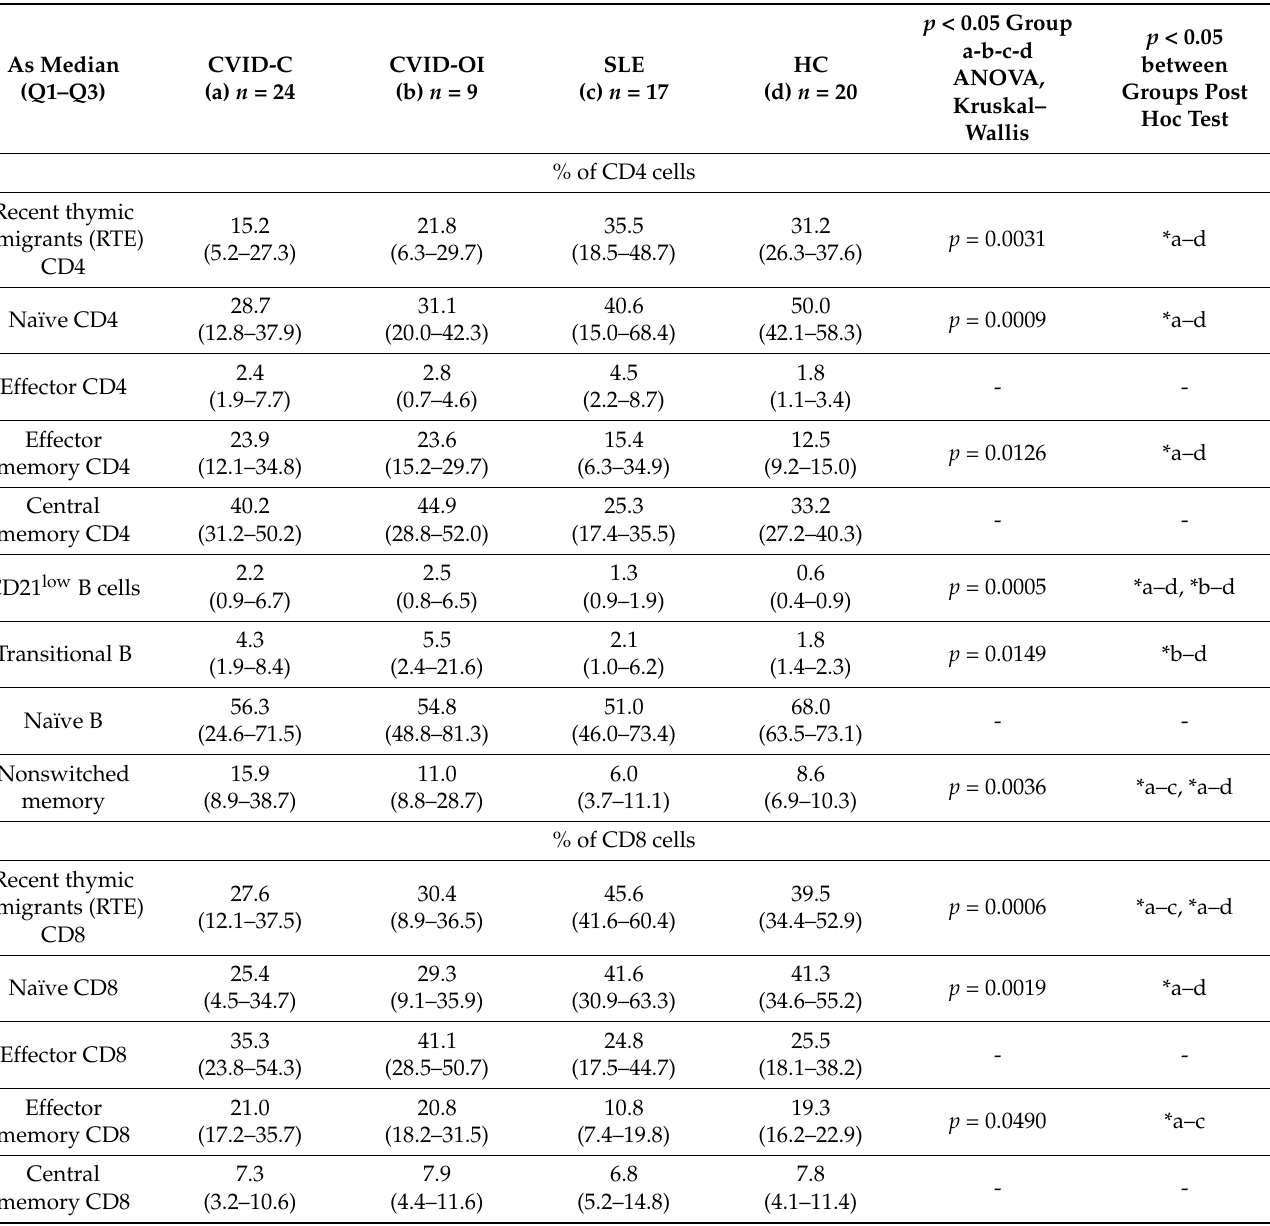
Table 4. Differences in the proportions of T lymphocytes maturation between (a) the CVID with complicated phenotype (CVID-C) group, (b) CVID phenotype limited to only infections (CVID-OI group), (c) patients with systemic lupus erythe- matosus (SLE), and (d) healthy controls (HCs). Data expressed as median (Q1–Q3), * p < 0.05. ANOVA: analysis of variance, Post Hoc: post hoc analysis